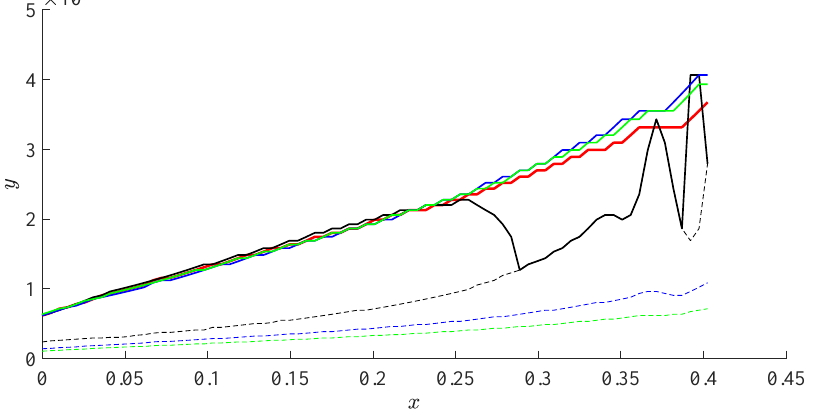
Figure 3. The function y BL ( x ) at tol H = 10 − 6 (red), and the functions ∆ v ( x ) (black), ∆ s ( x ) (blue), ∆ u ( x ) (green) at optimal values of adjustable constants c v , c s , c u (solid line) and at c v = c s = c u = 0 (dashed line) for the slice at the wing in Figure 1.